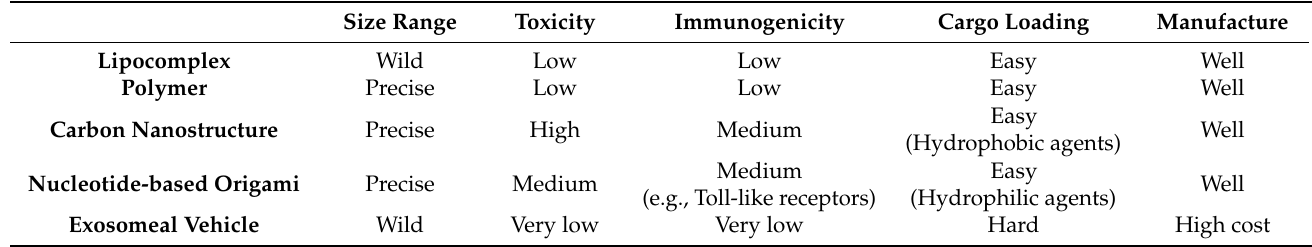
Table 3. Properties of different